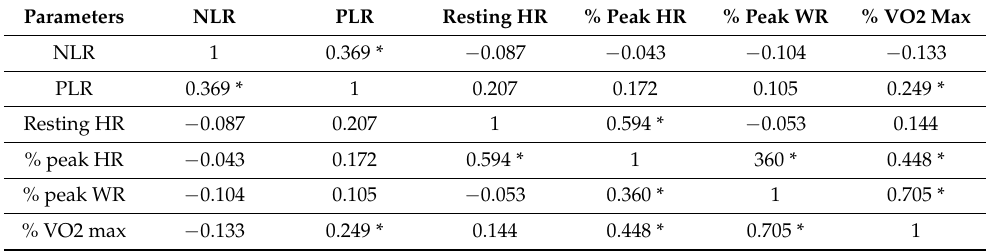
Table 3. Multivariate regression analysis to predict poor functional capacity.